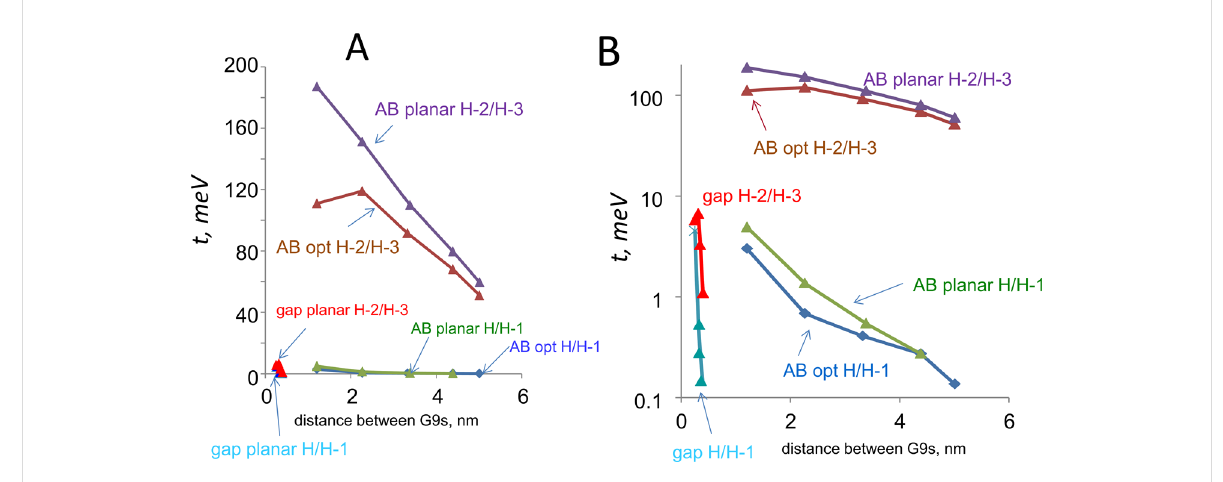
Figure 6: Comparisons of calculated electronic coupling t values in meV for G9–(AB) n –G9 and edge-oriented G9–gap–G9 structures. A) t for the indi- cated orbital combinations for G9–G9 gaps of varying width and for G9–(AB) n –G9 with varying numbers of AB subunits. t was determined between the HOMO and H − 1 orbitals for the system containing two G9 units (labeled H/H − 1) and for H − 2/H − 3 orbitals, as indicated. “opt” indicates optimized structures and “planar” structures were forced planar after optimization. B) same data as in panel A, but plotted on a logarithmic Y-axis. X axis is dis- tance between the closest carbon atoms in the G9